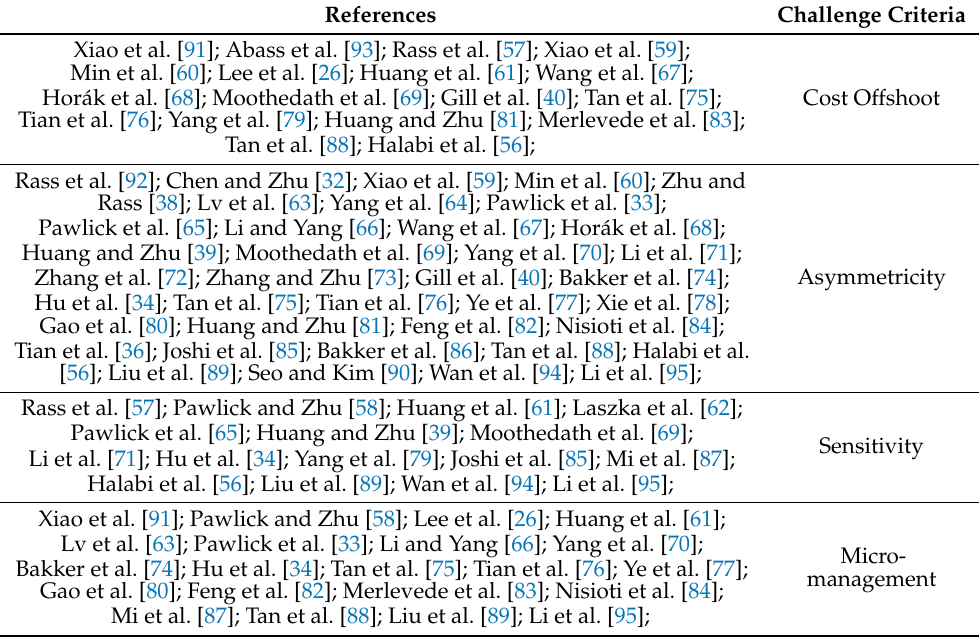
Table 7. Summary of the challenges of game-theory approaches against APTs based on the research